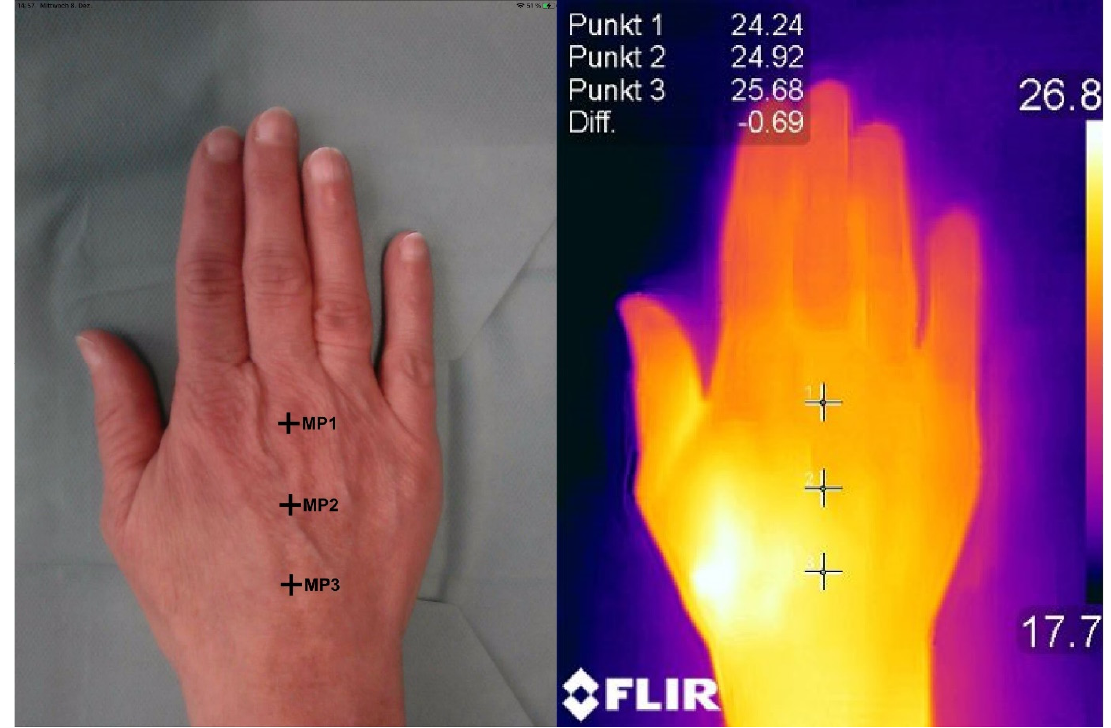
Figure 3. Skin temperature measured at three different measuring points (MP) with thermal